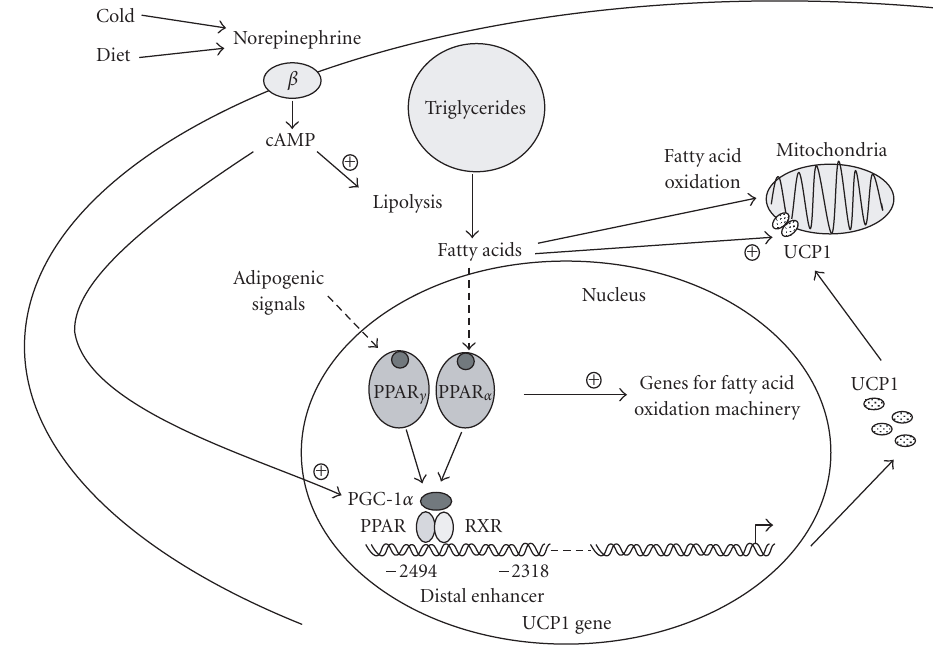
Figure 1: Schematic representation of the regulation of UCP1 gene expression by ligand-dependent activation of PPAR α and PPAR γ , and coactivation by PGC-1 α . The diagram shows the PPAR response element in the rat UCP1 gene enhancer (24). Major features of the transcrip- tional regulation of the mouse and human UCP1 genes appear to be similar (16,23). During brown adipocyte di ff erentiation, adipogenic signals activate transcription of the UCP1 gene through PPAR γ and coactivation by PGC-1 α , in concert with overall induction of adipocyte di ff erentiation towards the brown fat lineage. In response to thermogenic simuli on mature brown adipocytes, activation of PPAR α by lipolysis-derived fatty acids contributes to the coordination of UCP1 gene transcription (thermogenesis) with the lipid oxidation pathways providing metabolic fuel for